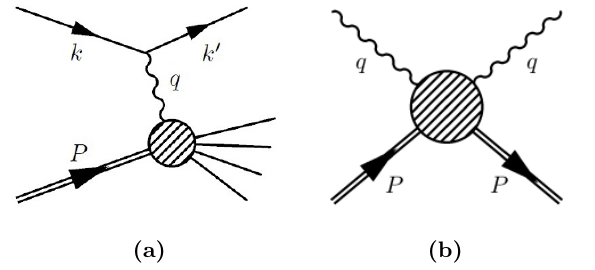
Figure 1. Schematic representation of DIS (a) and FCS (b) processes. k and k 0 denote the four-momenta of the incoming and outgoing leptons in